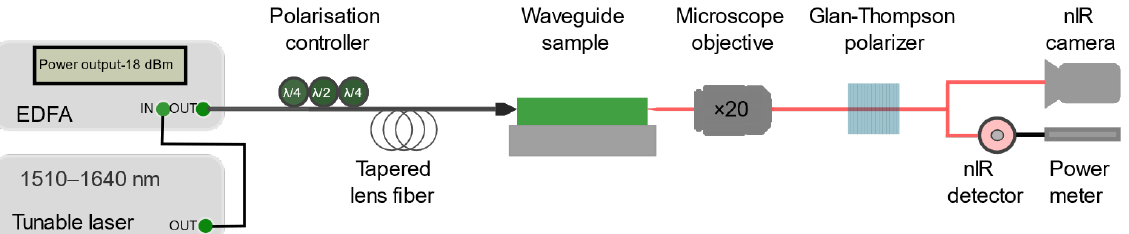
Figure 4. Schematics of the fiber characterization setup used to estimate the propagation losses in the waveguides using cut-back method. The detector of the power meter can be switched to a NIR camera for mode imaging. Different height lengths of waveguides were created for the propagation loss meas- urements. The transmission through each waveguide was measured five times, changing the injection side and the order of the measurement, i.e., from the longest to the shortest waveguide and vice versa. Results were averaged to obtain a single value used for the estimation of the propagation losses. 3. Results and Discussion